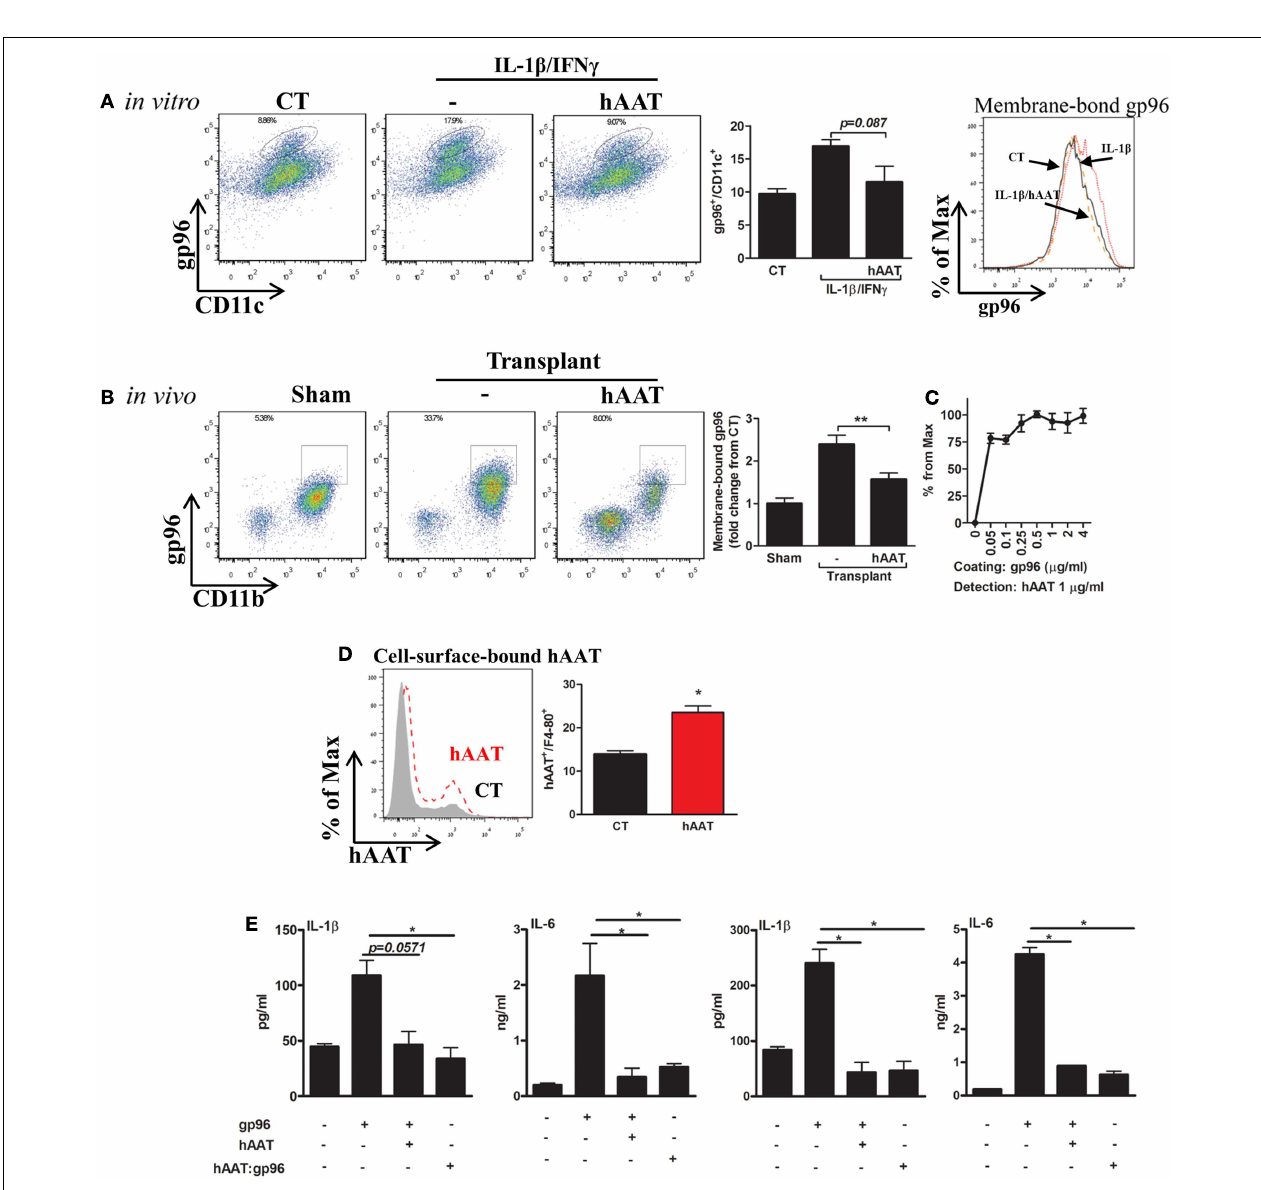
binding assay. ELISA-plate wells were coated with gp96 (0–4 µ g/ml) for 16h and then incubated for 3h with hAAT (1ng/ml). Captured hAAT was determined by HRP-conjugated anti-hAAT antibody. (D) Cell membrane-bound hAAT. Primary peritoneal macrophages (2 × 10 6 per well in quadruplicates) were incubated with hAAT (0.5mg/ml) for 16h and then stained with anti-hAAT antibody. hAAT binding to cell membranes was evaluated by FACS. CT, untreated cells. Representative results out of three independent experiments. (E) Pre-complexed hAAT:gp96. Freshly isolated primary mouse islets (30 per well in triplicates) or macrophages (4 × 10 5 per well in quadruplicates) were incubated with recombinant gp96 (50pM) in the presence or absence of hAAT (0.5mg/ml) or incubated with a complex of hAAT and gp96 (hAAT:gp96 at 0.5mg/ml and 50pM, respectively, for 1h). Cells were analyzed 48h later. CT, untreated cells. Representative results from three independent experiments. Mean ± SEM, * p < 0.05, ** p <